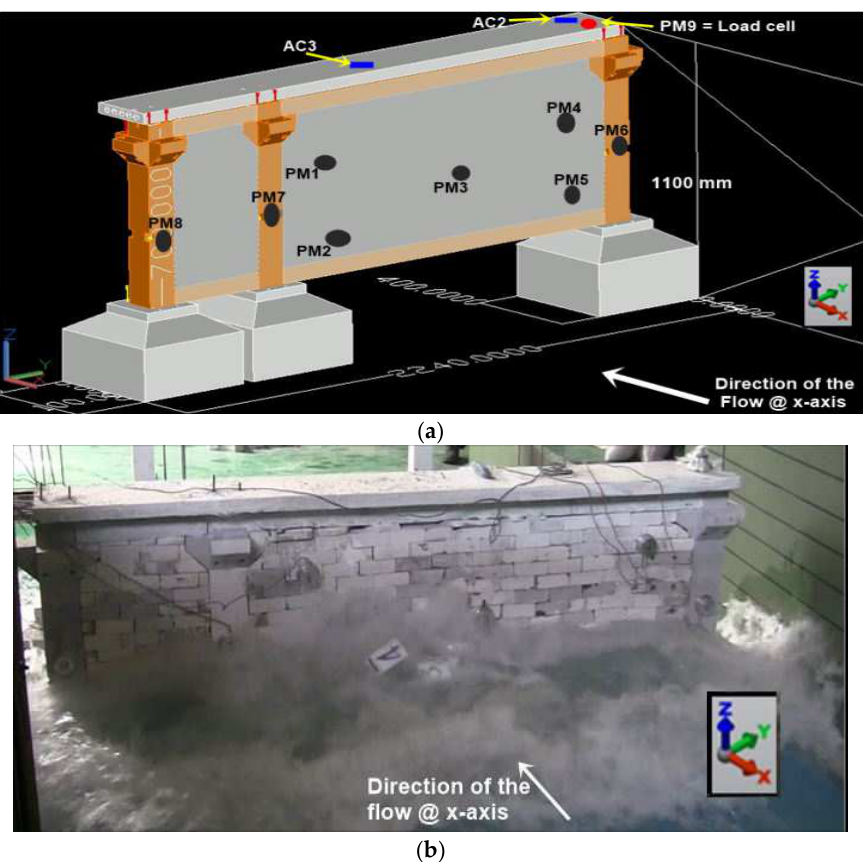
Figure 14. Dam-break test for 1 m reservoir water level: ( a ) schematic diagram of the dam-break test: ( b ) during test 1 of 2D frame.